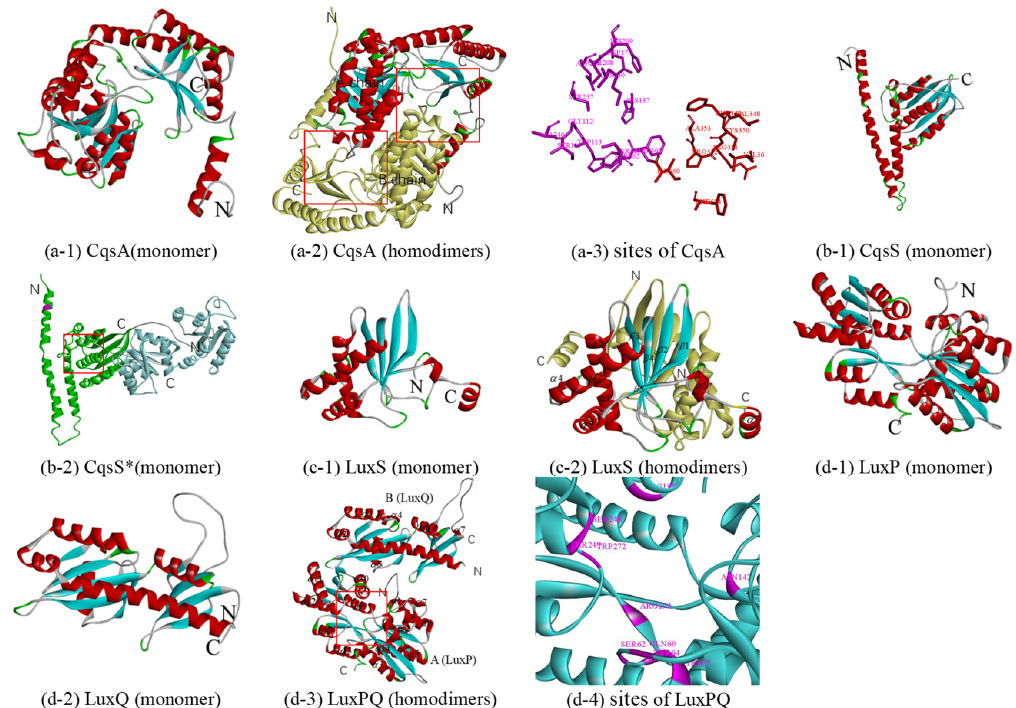
Figure 3. Predicted structure–function diagram for autoinducer synthases and receptor. ( a-1 ), ( b-1 ), ( c-1 ), ( d-1 ) and ( d-2 ) are the ribbon diagrams of monomers; ( a-2 ), ( c-2 ) and ( d-3 ) are the ribbon diagram of oligomers, where the red box refers to predicted binding-site and purple refers to the residues of the site; ( a-3 ) and ( d-4 ) are the active site or binding pocket site diagram of target proteins. In particular, ( b-2 ) is a monomer according to double template modeling, where the part templated by 2c2a is colored in green and that of 3luf is blue.